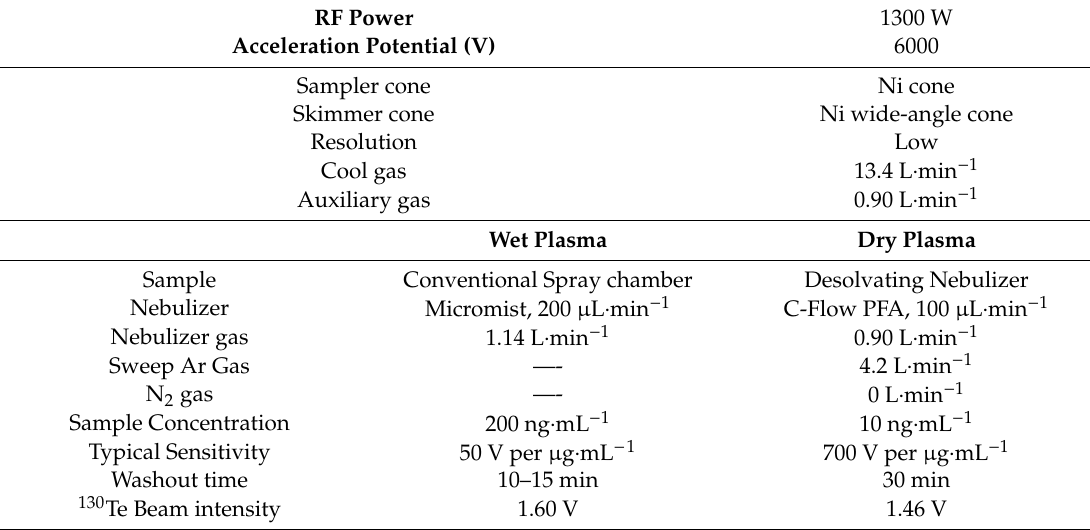
Table 4. MC–ICP–MS operating and measurement